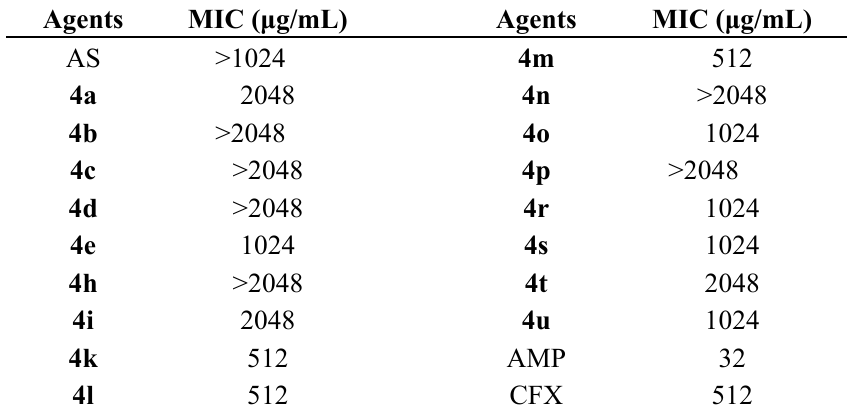
Table 1. MIC values of DHA derivatives, ampicillin and cefuroxime against E. coli AG100A/pET28a-AcrB. The MIC values were taken as the lowest drug concentrations at which observable growth was inhibited. Since 4f , 4g , 4j , and 4q were insoluble in LB broth, there was no MIC value for them. AMP, ampicillin; CFX, cefuroxime; 4a – u , DHA